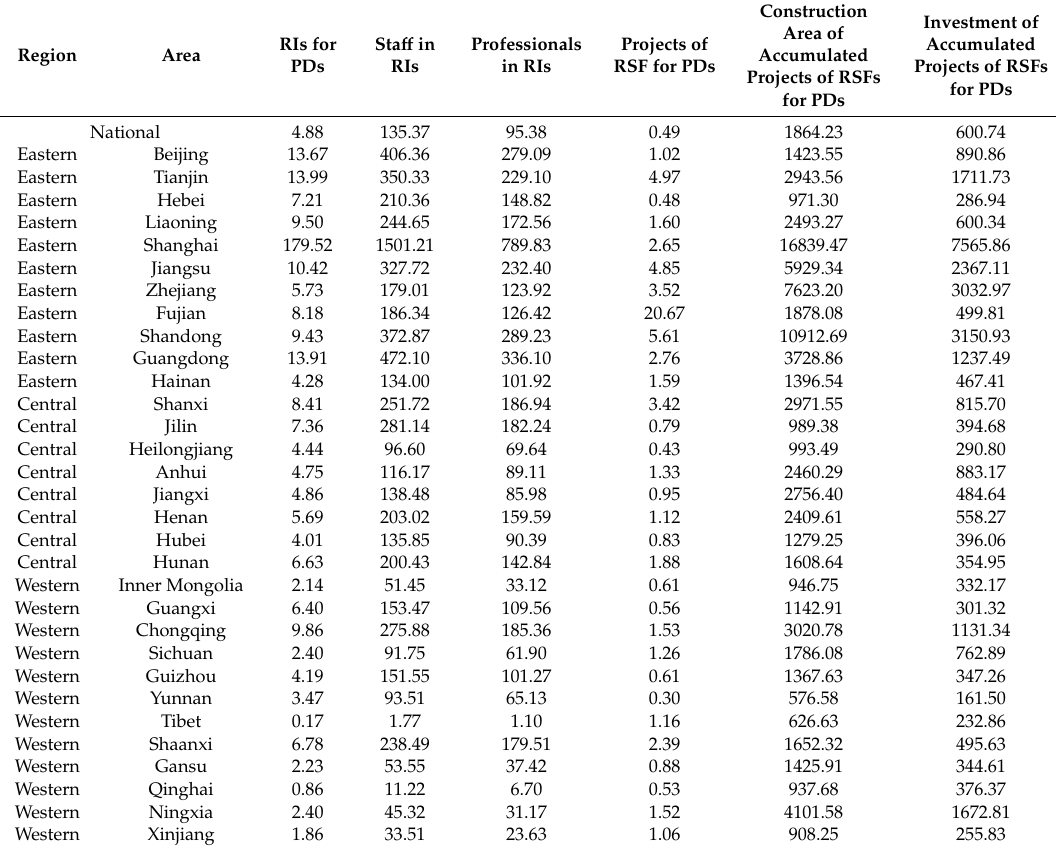
Table 4. Regional HRDI of rehabilitation resources for PDs in China in 2018.